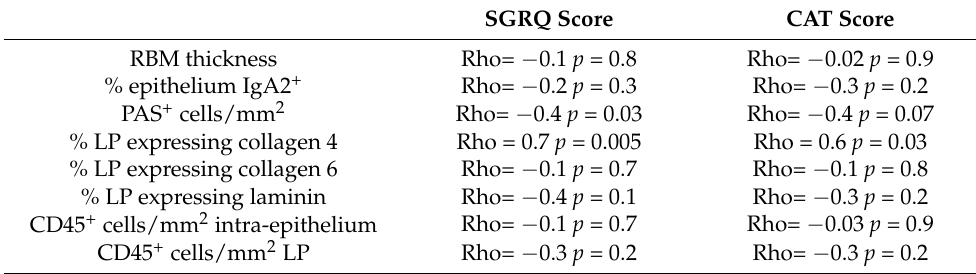
Figure 1. Quantification of reticular basement membrane thickness and goblet cells. The reticular basement membrane (RBM) thickness ( A – D ) and goblet cells ( E – I ) were compared between ( A , E ) COPD patients and smoking controls (S), with further detailed clinical phenotyping in COPD patients based upon ( B , F ) exacerbations, ( C , G ) airflow limitation, ( D , H ) smoking status, and ( I ) chronic bronchitis. Data presented as mean + SEM. Comparisons between groups were made by one-way ANOVA followed by Tukey’s test. Table 2. Relationship between histopathological measurements and symptom scores.